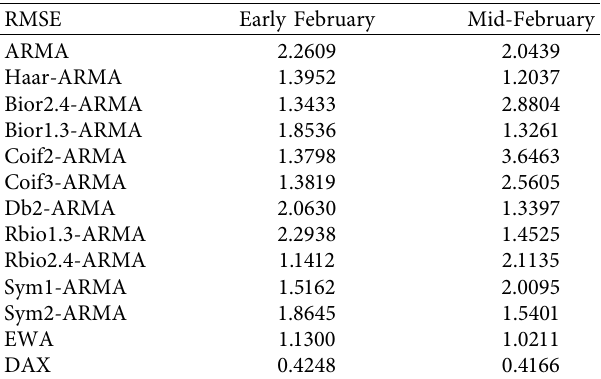
Table 2: The RMSE comparison between DAX, DA, and EWA